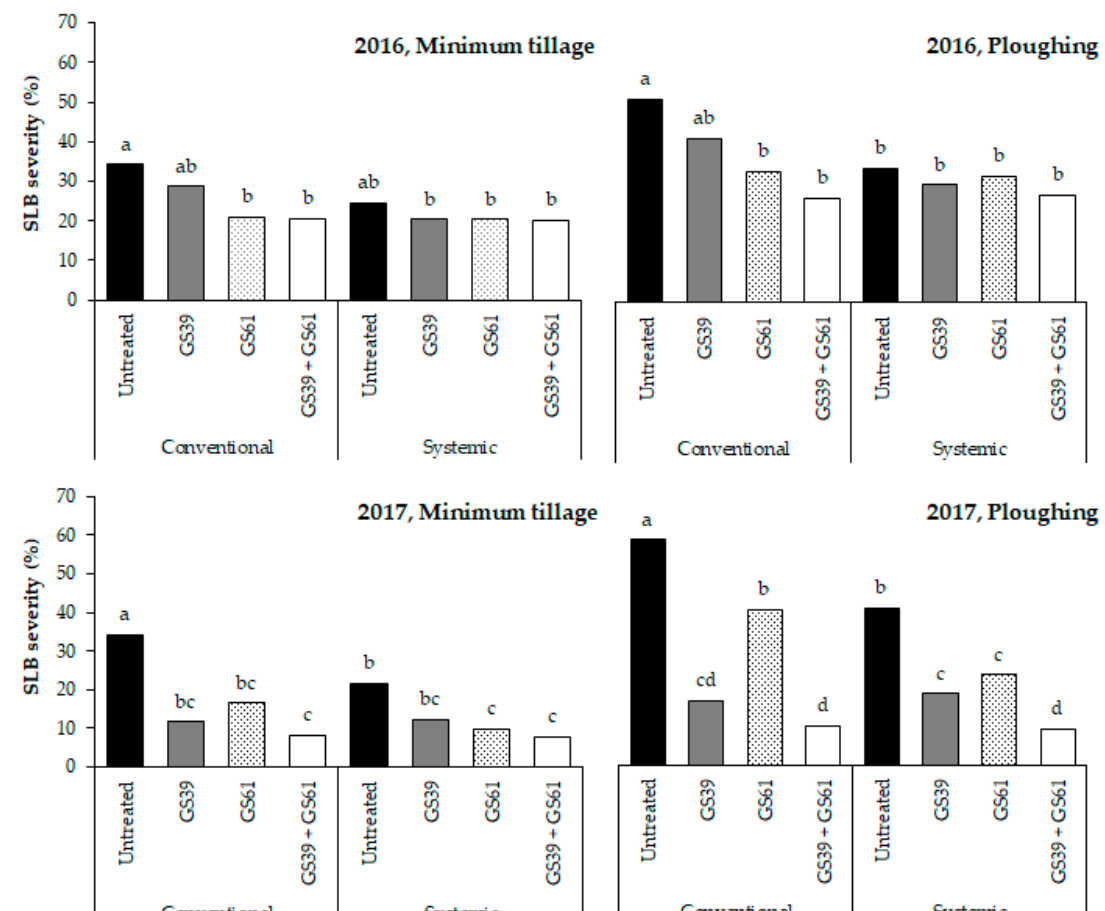
Figure 1. Effect of the fungicide seed 1 and foliar 2 treatments on Septoria Leaf Blotch (SLB) in different soil tillage and growing seasons (2015–2016 and 2016–2017) in North-Italy at the early dough stage (GS83). The bars in each experiment with different letters are significantly different ( p -value < 0.05), according to the REGW-F test. The reported values are based on four replications. 1 Fungicide seed treatments: conventional (fludioxonil AI) and systemic (fluxapyroxad AI). 2 Fungicide foliar treatment: untreated control; GS39, a single treatment at the end of stem elongation (pyraclostrobin + fluxapyroxad AI); GS61, a single treatment at the beginning of flowering (epoxiconazole + metconazole AI); GS39 + GS61, a double treatment through a combination of the GS39 and GS61 applications.